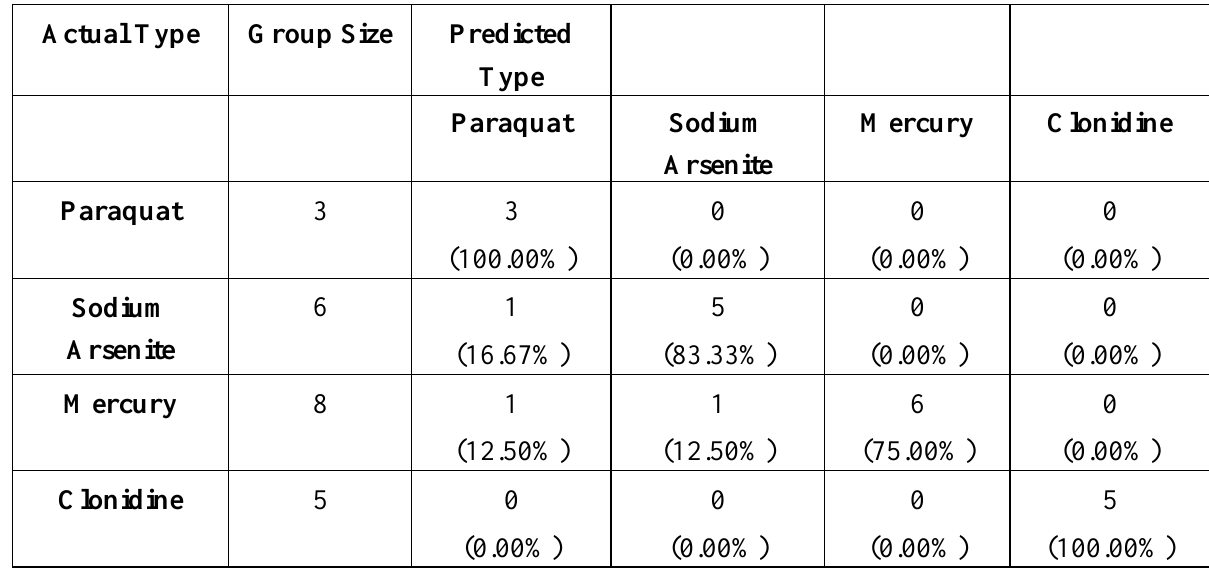
Table 3. Classification for Combined Case with six explanatory variables. This table represents a quantitative output of the classification efficiency of the discriminant functions for the combined case, which utilized both cell types. The table is read left to right and shows how the discriminate functions predicted the toxin that was present following the training procedure. Overall classification efficiency was